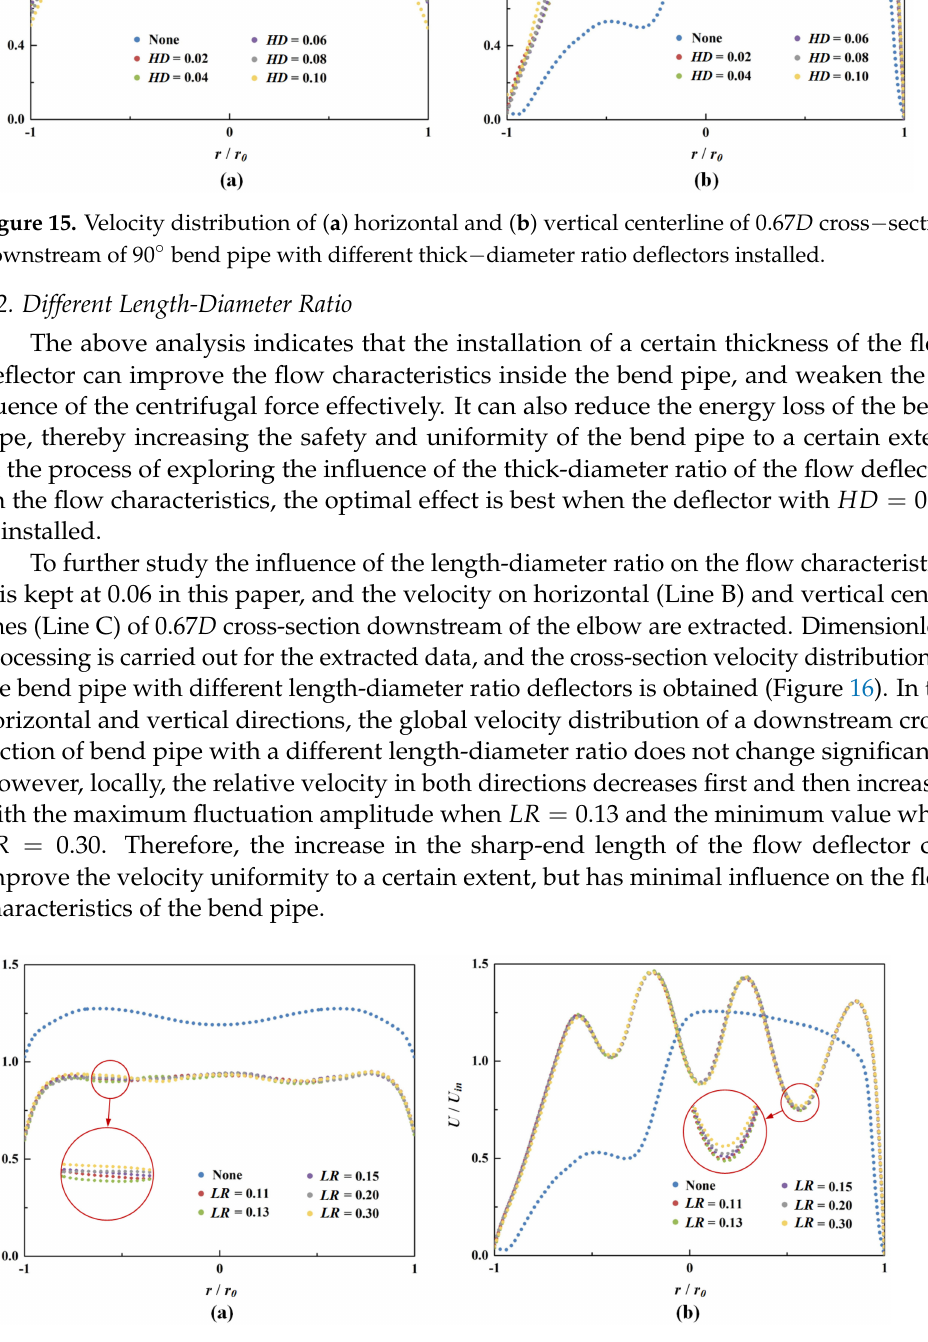
Figure 16. Velocity distribution of ( a ) horizontal and ( b ) vertical center line at 0.67 D cross − section downstream of 90 ◦ bend pipe with different length − diameter ratio deflectors